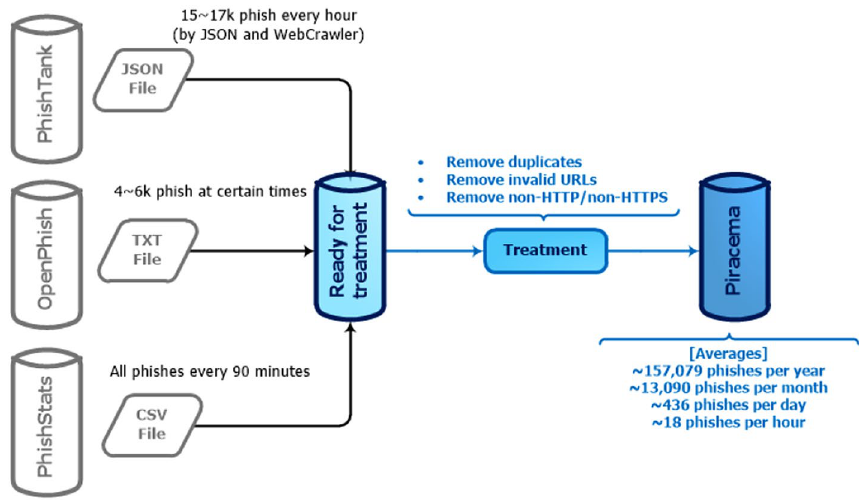
Figure 1. Extraction of phishing logs in each repository.